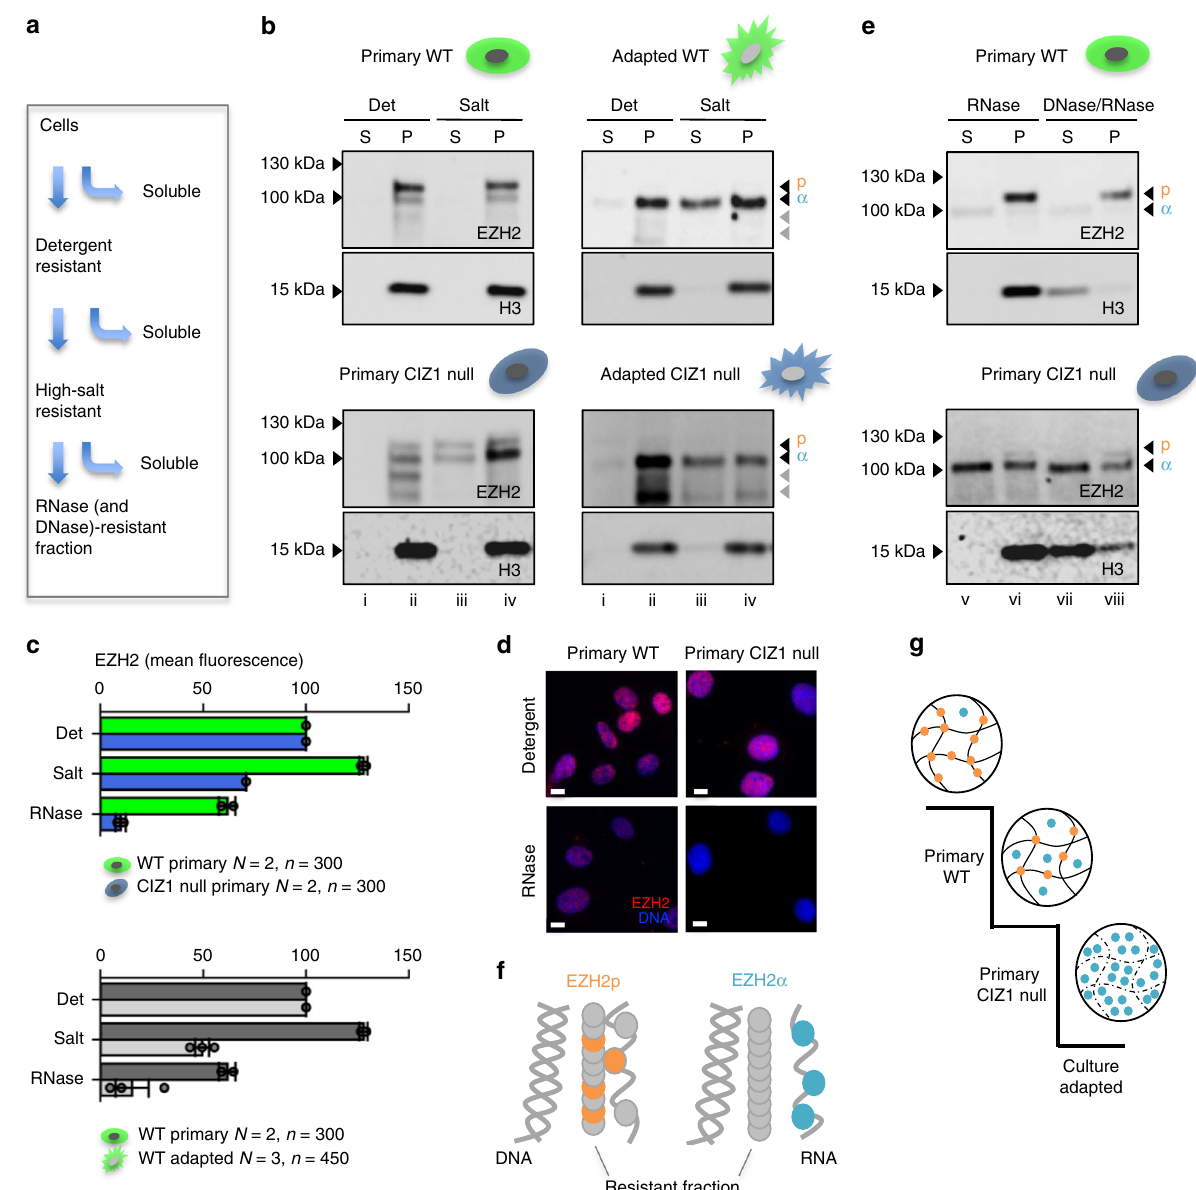
Fig. 6 Loss of CIZ1 drives changes in EZH2 binding. a Schematic showing sequential extraction with detergent-containing buffer (0.1% Triton X100), high- salt buffer (500 mM NaCl), and nucleases (RNase and/or DNase1), detailed in Methods. b Representative western blots showing partitioning of EZH2p and EZH2 α (antibody D2C9) into soluble (S) and pellet (P) fractions, after incubation with detergent (Det) or with detergent plus 500 mM NaCl (Salt). All fractions within an extraction series are cell-equivalents. Results are shown for primary WT (13.8 p3) and CIZ1 null cells (13.17 p5) and culture-adapted derived populations (p28 – 29) of each genotype. Fraction numbers i – iv relate to the full serial extraction protocol in Methods. c Quanti fi cation of EZH2 immuno-stain in two primary cell populations of WT (13.1, 13.8) and CIZ1 null (13.17, 14.2) genotypes after the indicated extraction steps. Histogram shows mean fl uorescence intensity normalized to detergent-treated samples, ±SEM, where n > 50 for each genotype and condition, and N = 2. Below, the same analysis comparing two WT primary cells and three WT culture-adapted cells (13.1, 14.4, 3T3 cells). Individual data points contributing to the mean are overlaid. d Images show EZH2 (red, D2C9) after detergent-extraction and after RNase-extraction. DNA is blue, scale bar is 10 microns. e The salt-resistant pellet fraction (iv in e ) from primary cells, was further partitioned by digestion to solubilize RNA, or both RNA and DNA as indicated, revealing complete nuclease-resistance of EZH2p in WT cells, despite ef fi cient release of histone 3 (H3) into the soluble fraction. In contrast, in CIZ1 null cells (expressing EZH2 α ) more than half is sensitive to solubilisation with RNase. Fraction numbers v – viii relate to the full serial extraction protocol in Methods. f Illustration of the differing modes of attachment of EZH2 α (released along with RNA), and EZH2p (immobilized by attachment to RNase and DNase-resistant assemblies). g Model illustrating two drivers of the shift away from immobilized EZH2p (primary WT cells) towards the expression of high levels of non- immobilized EZH2 α (culture-adapted cells). CIZ1 null primary cells represent an intermediate